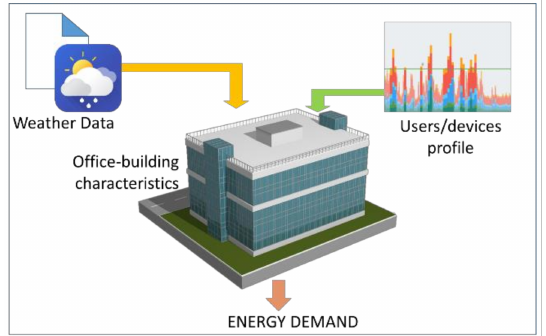
Figure 2. Schematic diagram for building’s energy